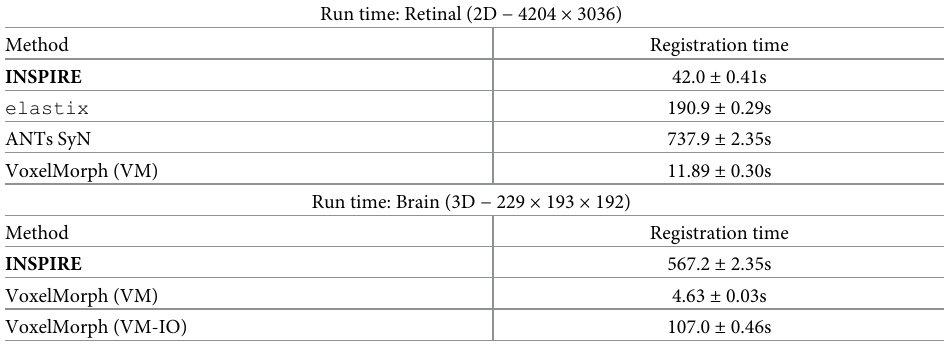
Table 5. Run time of the methods for 2D and 3D